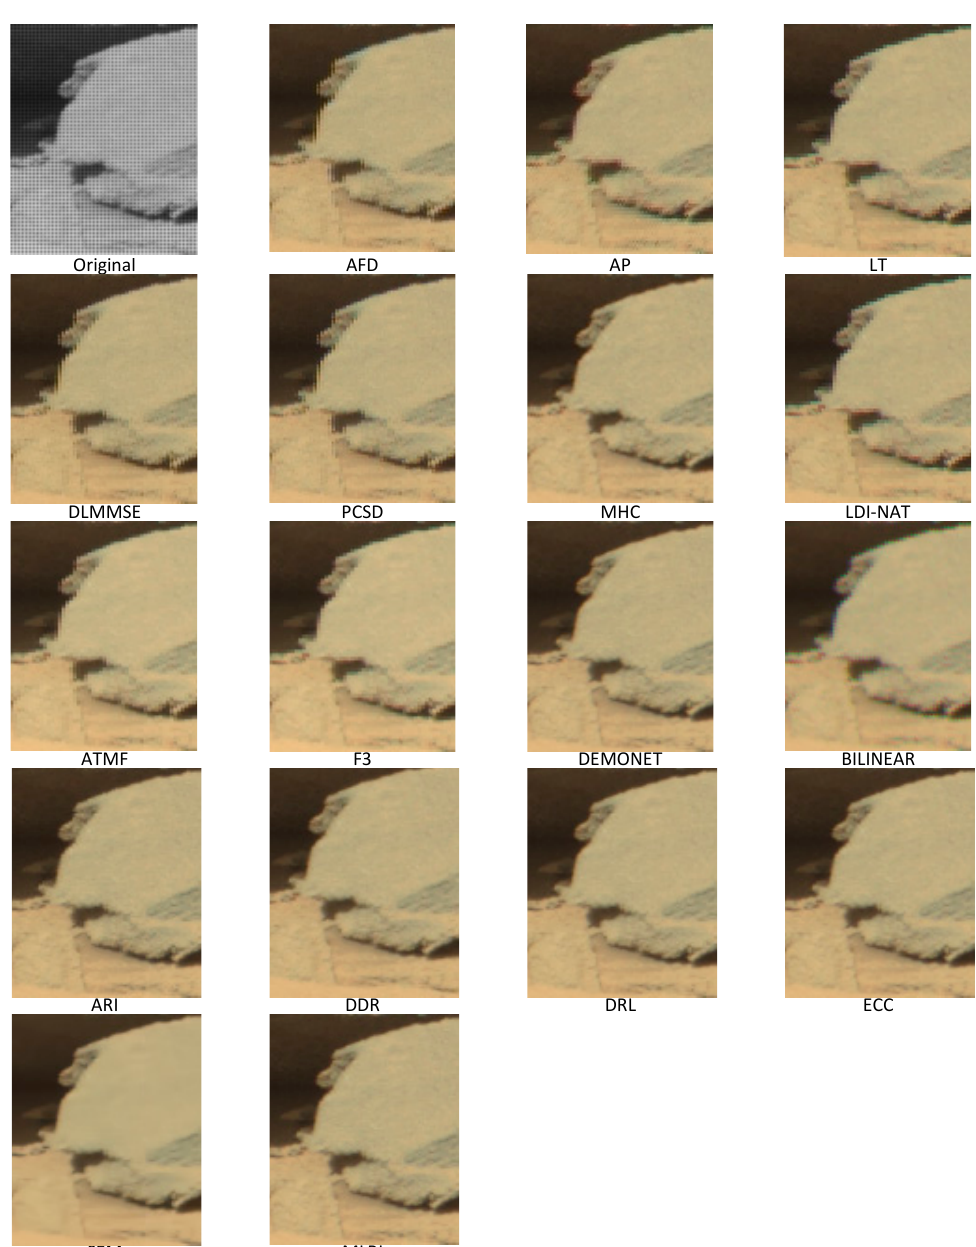
Figure 11. Subjective comparison of demosaiced images of different algorithms for right Mastcam image 1.